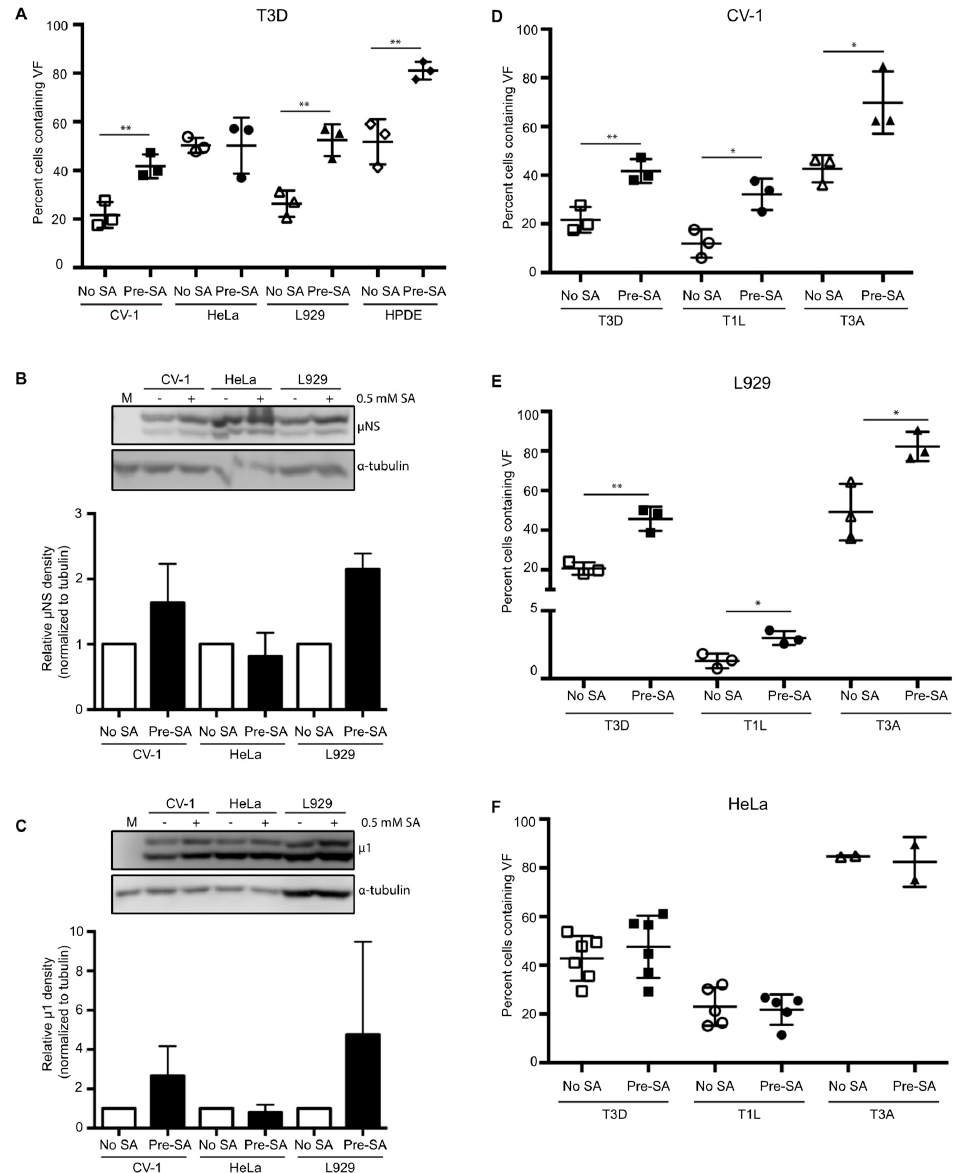
Figure 3. Pre-treatment with 0.5 mM sodium arsenite (SA) enhances permissivity in a cell-type-specific manner across reovirus strains. ( A ) CV-1, HeLa, L929, or HPDE cells were left untreated (no SA) or were treated with 0.5 mM SA for 30 min prior to infection (Pre-SA). Following this, cells were infected with T3D such that ~20% to 50% of cells were infected and at 18 h p.i. cells were fixed and immunostained for µ NS and DAPI to visualize viral factories (VFs). The percent of cells containing VFs was quantified ((# of cells containing VFs / total # of cells) × 100) from three independent experiments. The expression level of µ NS ( B ) and µ 1 ( C ) was determined in CV-1, L929, or HeLa cells either left untreated (no SA) or treated with 0.5 mM SA for 30 min (Pre-SA) before infection with T3D at MOI = 1. At 18 h p.i., cells were harvested and the expression level of the indicated proteins was determined by immunoblot. M = mock. Densitometry analysis of the band intensity for µ NS and µ 1 was adjusted to the matched α -tubulin loading control for two independent experiments. Columns represent mean ± SEM. ( D ) CV-1; ( E ) L929; or ( F ) HeLa cells were left untreated (no SA) or were treated with 0.5 mM SA prior to infection (Pre-SA). Cells were then infected with the reovirus strains, T3D, T1L, or T3A, as described in (A). At 18 h p.i., cells were fixed and immunostained for µ NS and DAPI to detect VFs. The percent of cells containing VFs was quantified ((# of cells containing VFs / total # of cells) × 100) from at least two independent experiments. * p < 0.05; ** p < 0.01; two-tailed unpaired t test. The error bars indicate